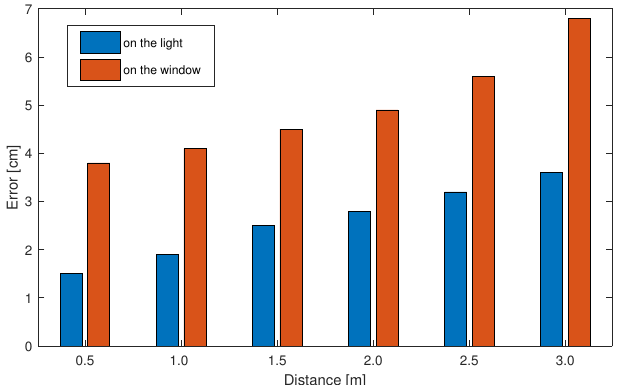
Figure 11. Influence of vertical distance between light source and camera position.